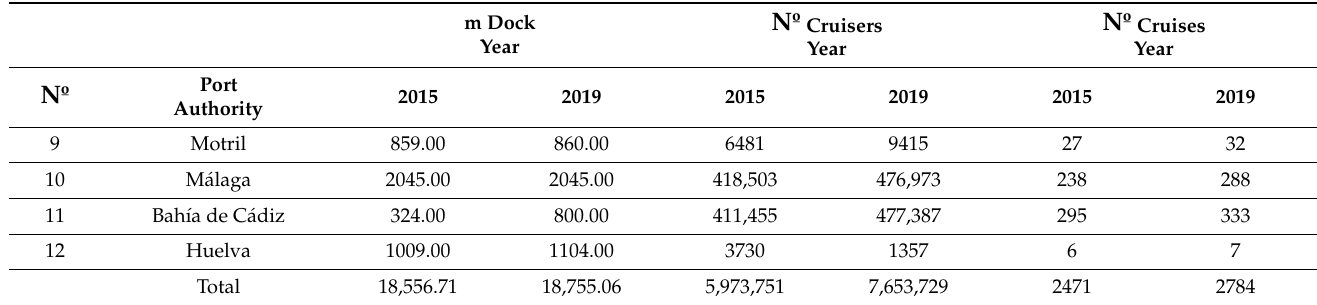
Table 2. Cont. Table 2. Port data set to determine efficiency. Table 2. Port data set to determine efficiency.